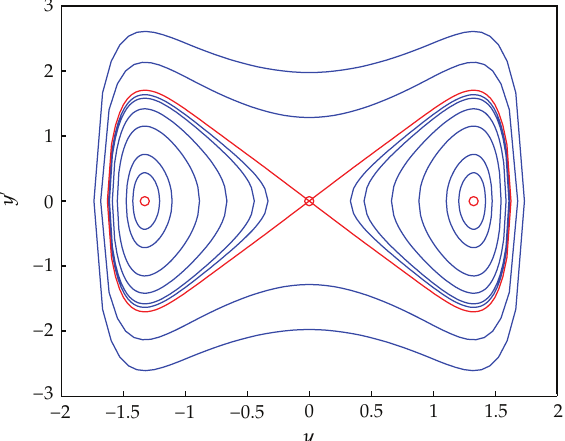
Figure 2: Phase portrait of critical equation (cid:2) 4.16 (cid:5) , where s α (cid:6) − 1 and (cid:7) α <